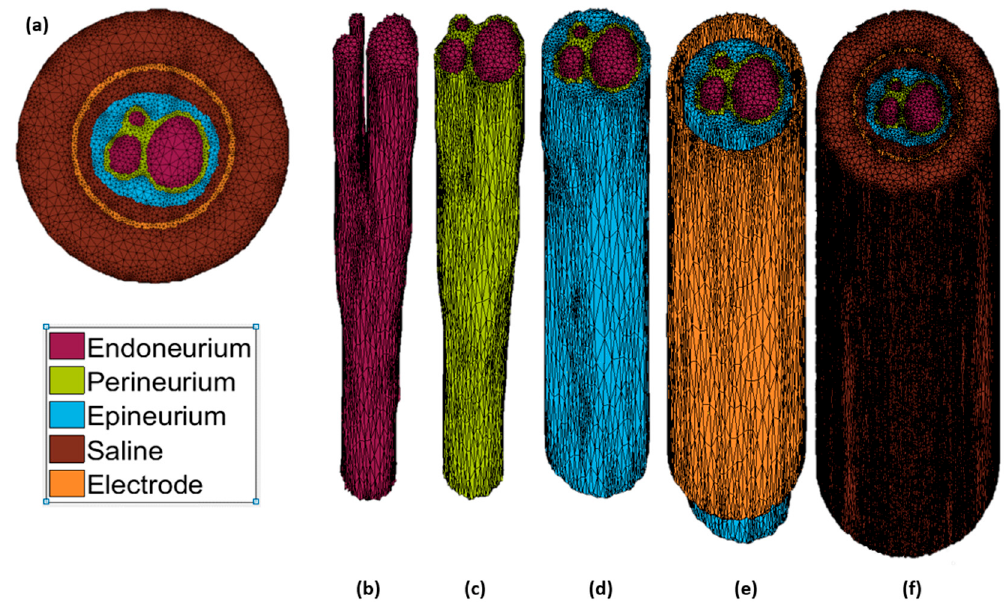
Figure 1. Finite element (FE) tetrahedral mesh model. ( a ) Top–down view of the base FE mesh model. Individual layers of the FE mesh model: ( b ) endoneurium, ( c ) perineurium, ( d ) epineurium, ( e ) cuff electrode, and ( f ) saline.